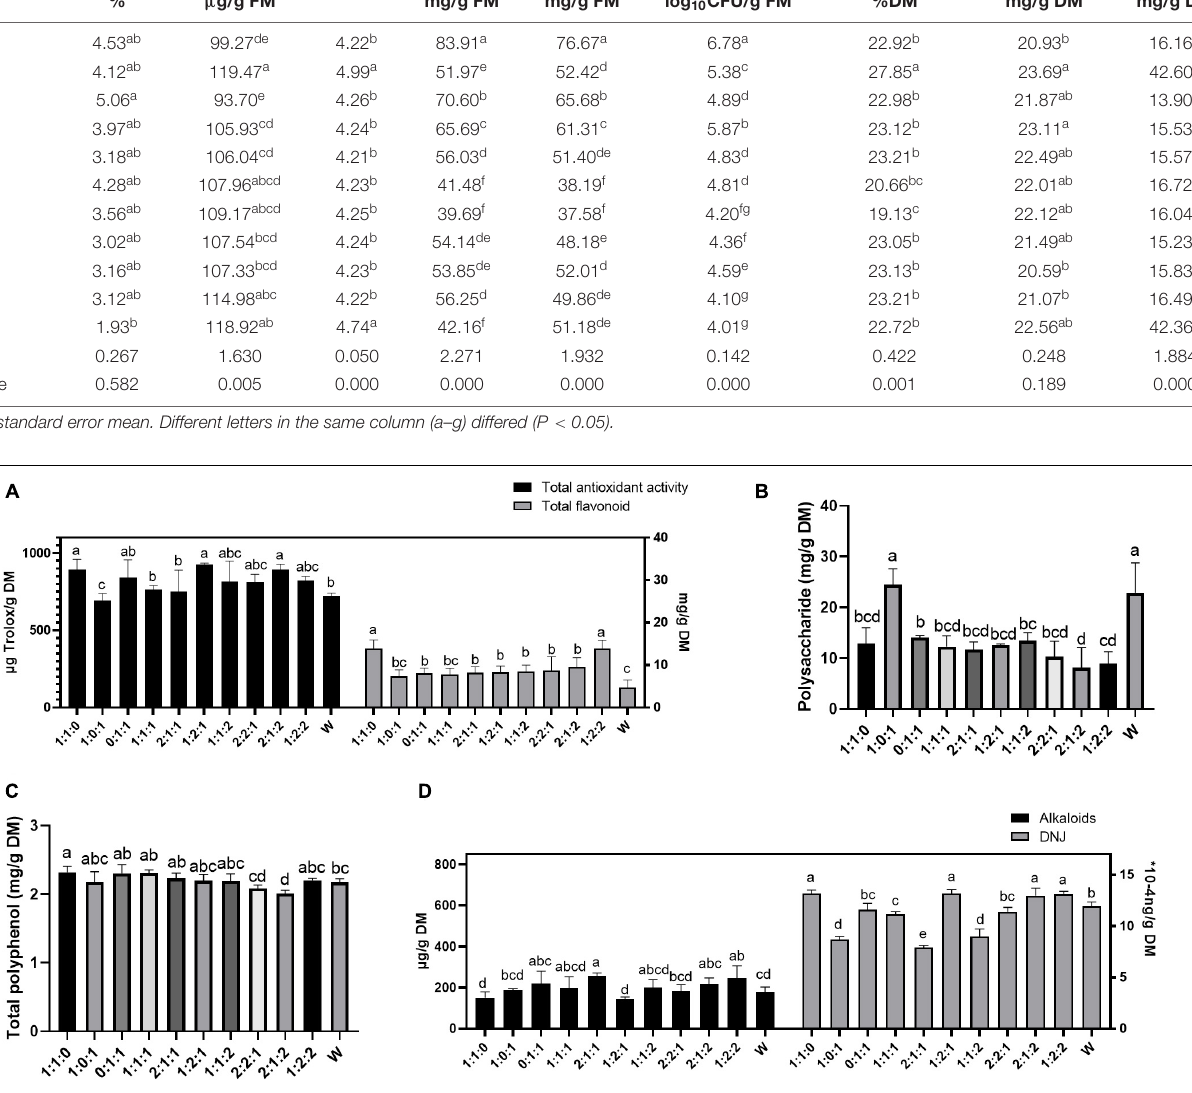
FIGURE 1 | Total antioxidant activity and total flavonoid (A) , polysaccharide (B) , total polyphenol (C) , and alkaloids and DNJ (D) of mulberry leaves ensiled with different inoculant ratios in trial 1 . Different letters in the same index among groups differed ( P <